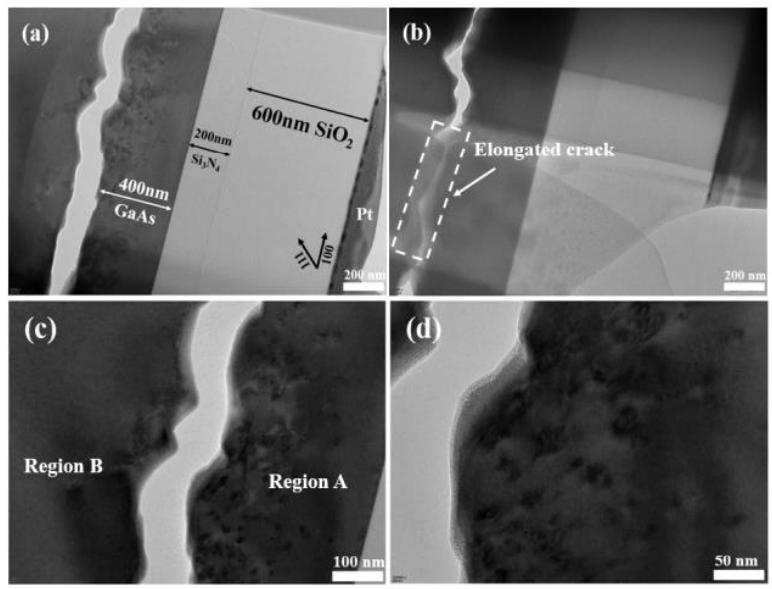
Figure 6. Cross-sectional TEM images of Sample D. ( a ) An overall cross-sectional morphology of Sample D; ( b ) Partial micro-cracks of the damaged zone; ( c ) Dislocation-like defects; ( d ) A close view of dislocation-like defects.